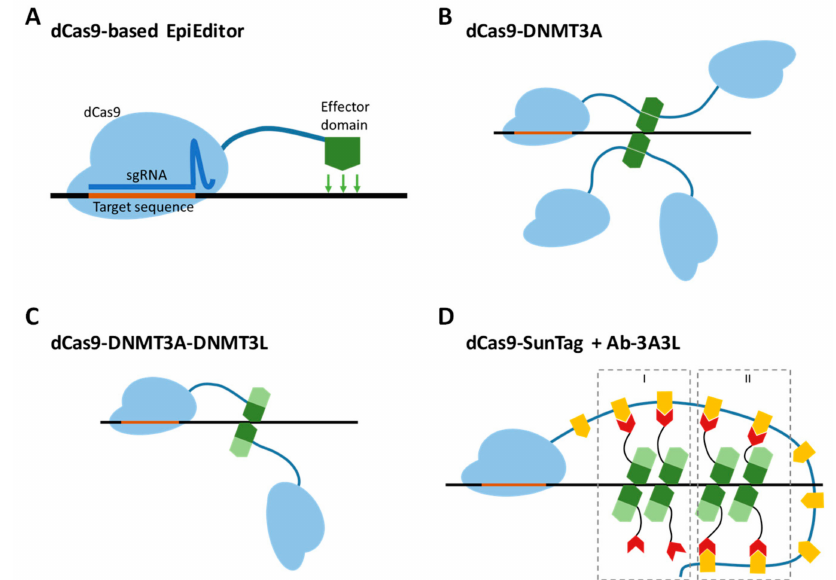
Figure 1. EpiEditors for targeted DNA methylation. ( A ) General design of an EpiEditor containing a chromatin-modifying enzyme (e ff ector module, green) fused to a catalytically deactivated Cas9 protein (dCas9, light blue) in complex with a single guide RNA (sgRNA, dark blue) complementary to the target genomic locus. ( B ) The direct fusion protein of dCas9 and the C-terminal domain of DNMT3A form a tetramer at a target site to produce a catalytically active complex. ( C ) The dCas9 direct fusion protein with the fused C-terminal domains of DNMT3A (dark green) and DNMT3L (light green) form an active complex by dimerization. ( D ) Co-expression of two chimeric proteins, dCas9-SunTag and Ab-3A3L (containing the fused C-terminal domains of DNMT3A and DNMT3L, dark and light green), leads to the formation of active complexes by dimerization of recruited and free Ab-3A3L (mechanism I) or only by interaction of two recruited Ab-3A3L dimers (mechanism II). The orange shapes represent the GCN4 peptide sequence, the red shapes represent the scFv antibody binding to the GCN4